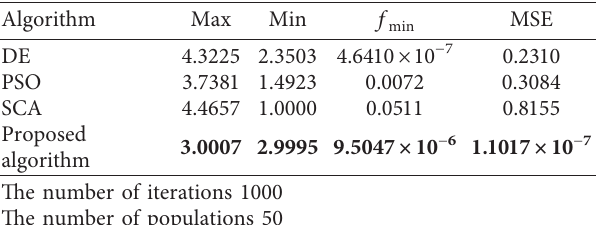
Figure 6: The model of a scattered field. Table 6: The results of the algorithm performance comparison.